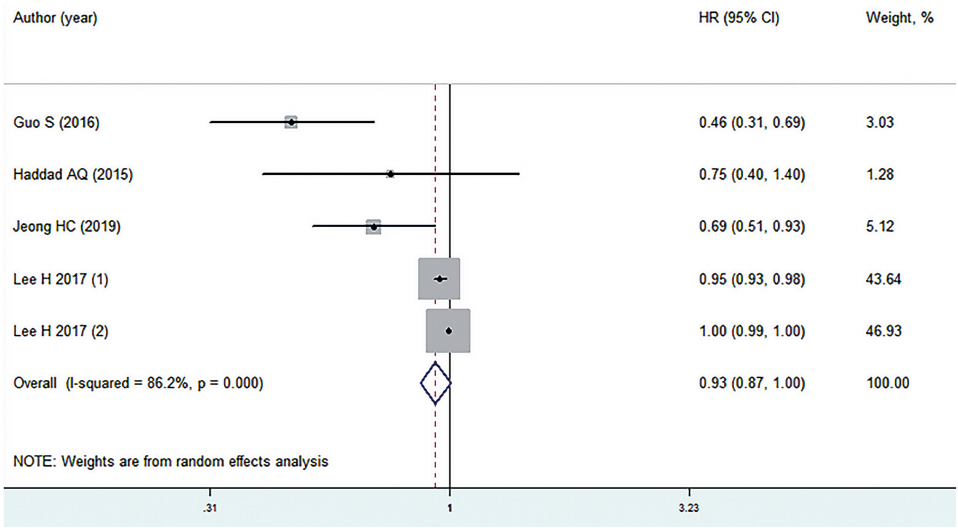
Figure 2 - Preoperative serum TC levels and OS in patients with surgically treated